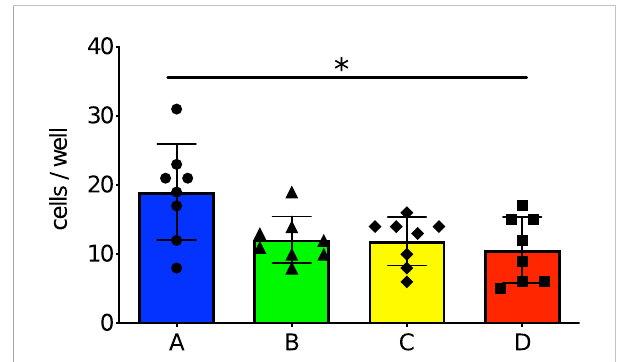
FIGURE 2 Number of anti-PspA speci fi c IgG producing cells in the spleens of 7-day old offspring. The splenocytes were incubated with 5 µg of rPspA overnight, then incubated in polyvinylidene di fl uoride membrane 96 wells coated with rPspA overnight. After the cells were removed, the immobilized antibodies on the membrane were incubated with biotinylated detection antibody to mouse IgG, then incubated with alkaline phosphatase conjugates with streptavidin. The spots were visualized by BCIP/NBT. Circle and blue bar; Group A (n=8), triangle and green bar; Group B (n=8), diamond and yellow bar; Group C (n=8), square and red bar; Group D (n=8). Each dot represents individual data of the mouse. Each data is shown as mean with standard error of the mean. Kruskal-Wallis test with Dunn ’ s multiple comparison was performed for a comparison between the groups. *; P